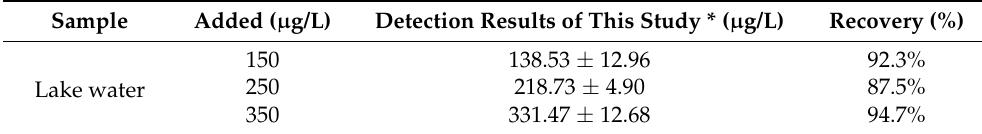
Table 3. Adding standard recovery test results.